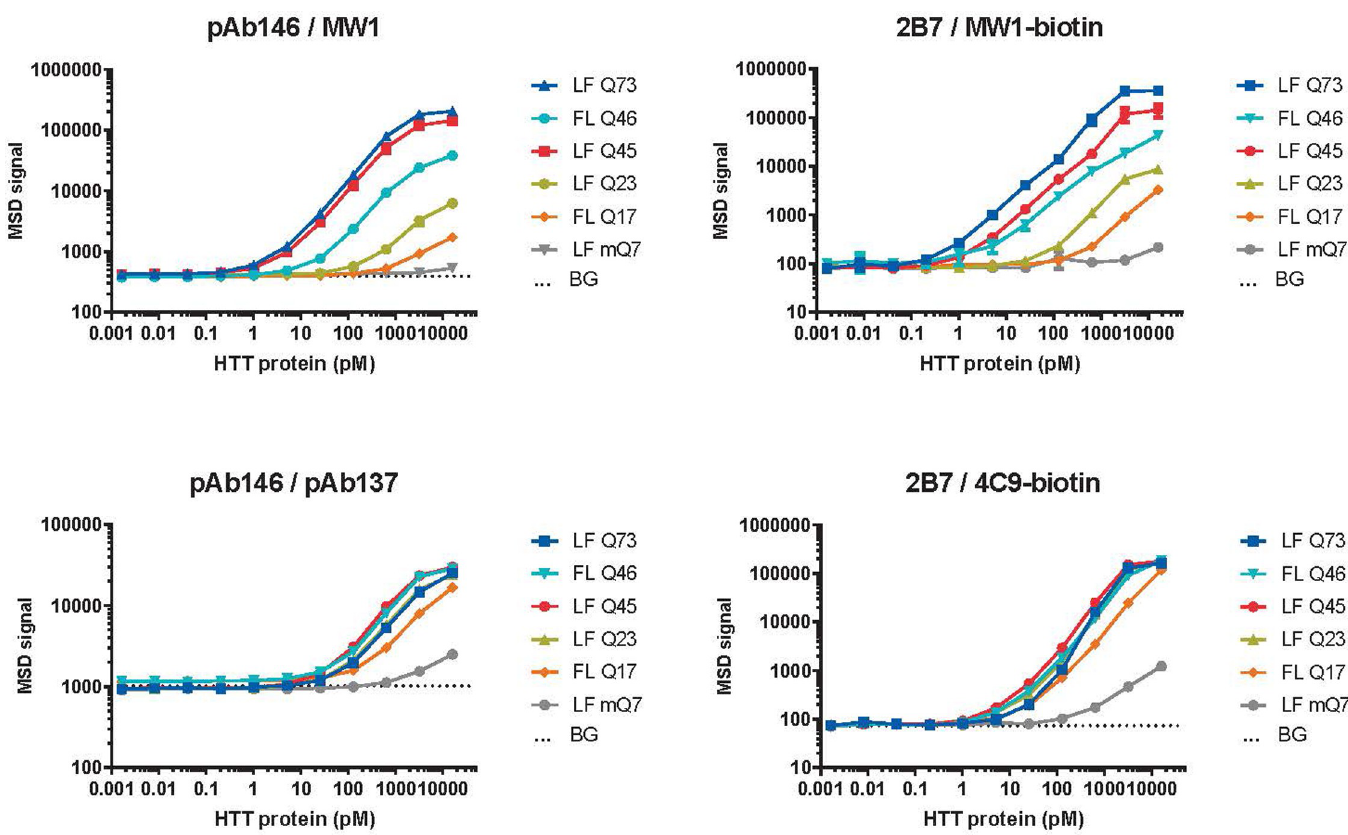
Fig 2. Enhanced sensitivity and dynamic range in HTT MSD assays employing only monoclonal antibodies compared to assays using polyclonal antibodies. Recombinant human HTT proteins of different fragment length (1–573 or full length) and Q length, and mouse HTT-Q7 (1–549) large fragment (LF) were spiked into MSD lysis buffer 1 and analyzed with expanded polyglutamine HTT assays employing antibody pairs pAb146/MW1 (‘polyclonal assay’) or 2B7/MW1 (‘monoclonal assay’), or with exon-1 pan-human HTT assays employing antibody pairs pAb146/pAb137 or 2B7/4C9. Mean ± s.d. of n = 4 technical replicates obtained from two different MSD plates. BG, background signal obtained from MSD lysis buffer 1. Horizontal dotted lines indicate LLoD calculated from BG + 3 standard deviations using the LFQ73 curve. LF, large N-terminal fragment (N573) of human HTT; FL, full length human HTT. Please note that antibodies are shown in the order of capture / detection. Please note that the error bars are smaller than the symbol used in the graph and therefore cannot be seen.